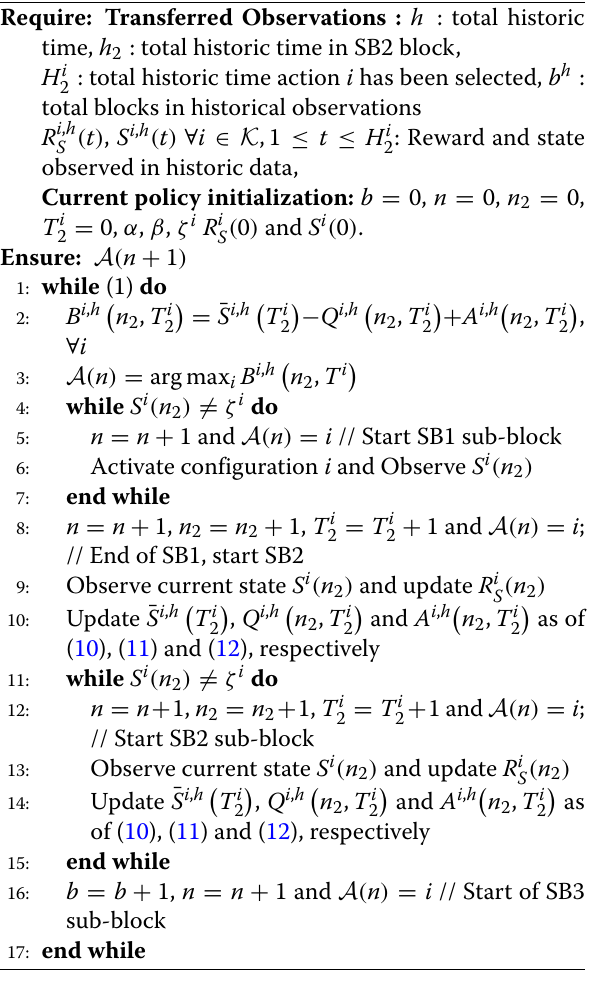
Algorithm 1 TLEEM-UCB